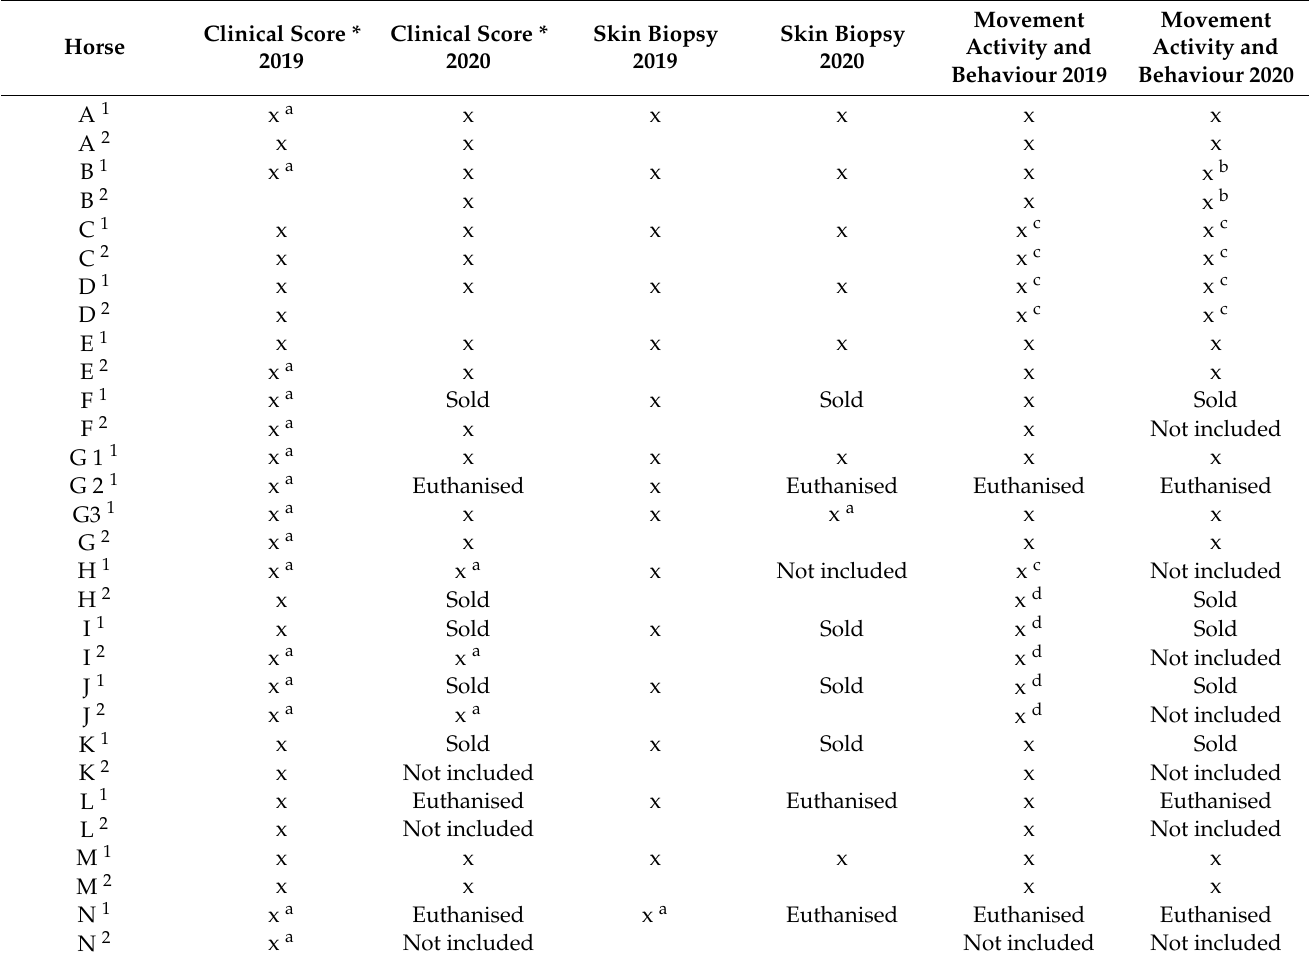
Table 2. Type of data collected for horses affected by insect bite hypersensitivity (IBH) and control horses during 2019 and 2020. A cross indicates that the data type was collected for a